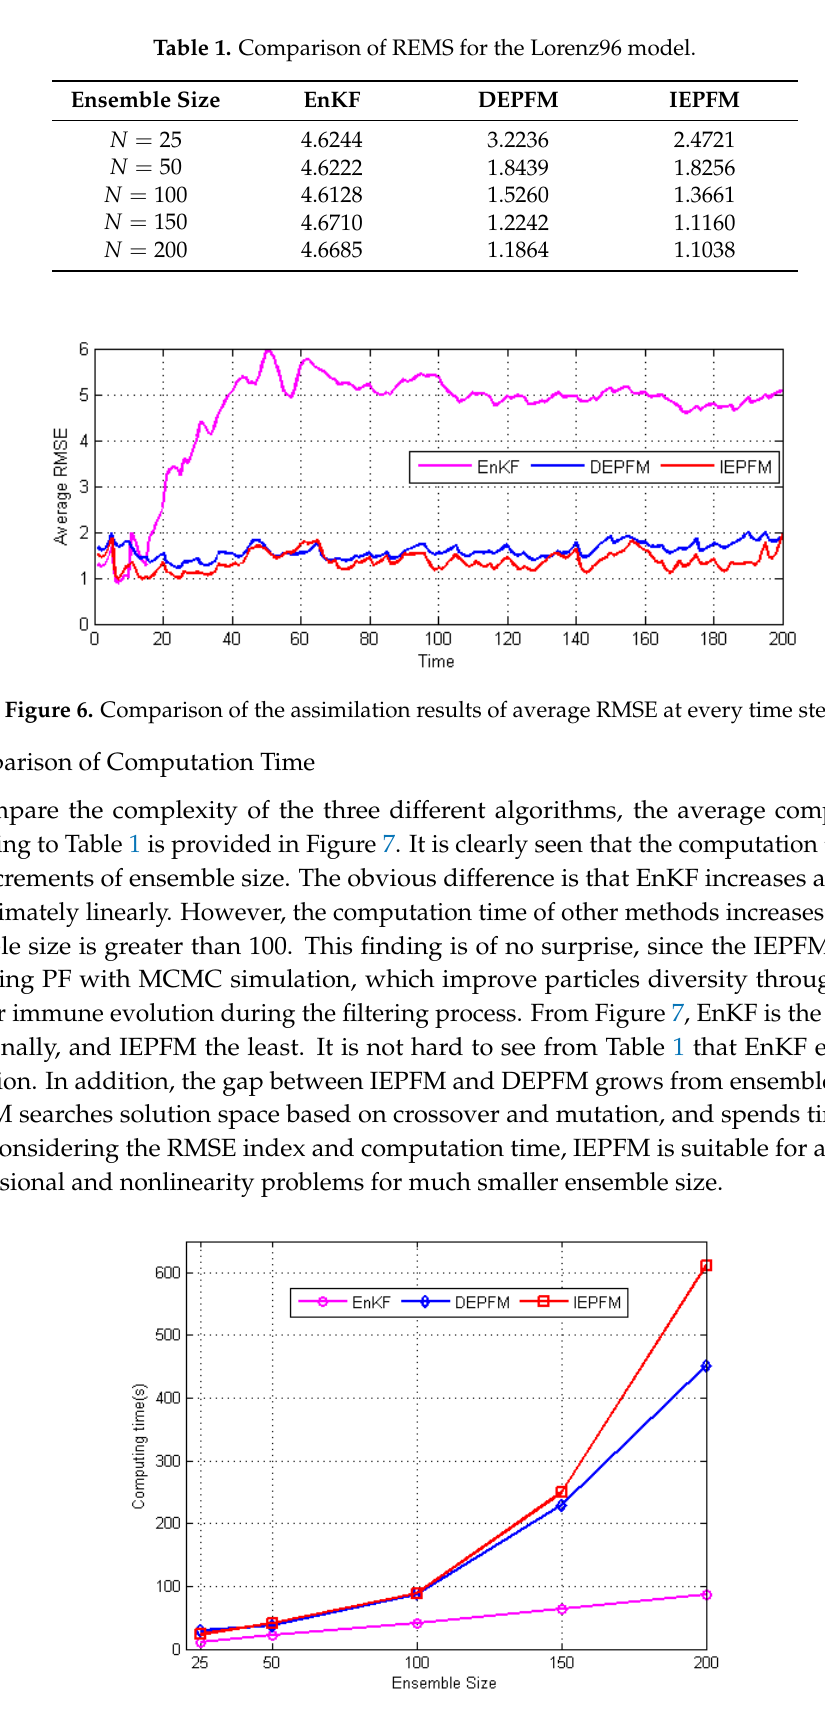
11 Figure 5. Bar plots of the RMSE and computing time with the same conditions. 3.1.2. Performance Comparisons Three DA algorithms with different particles or ensemble members are simulated for 200 time steps and the state variables are estimated by assimilating the observations into the Lorenz96 model. All 40 state variables are selected for comparison. The average RMSEs of 30 independent runs are used to evaluate the performance of DA algorithms. In addition, for IEPFM, the crossover probability c p and the mutation probability are set to 0.8 and 0.3, respectively. The parameters of DEPFM